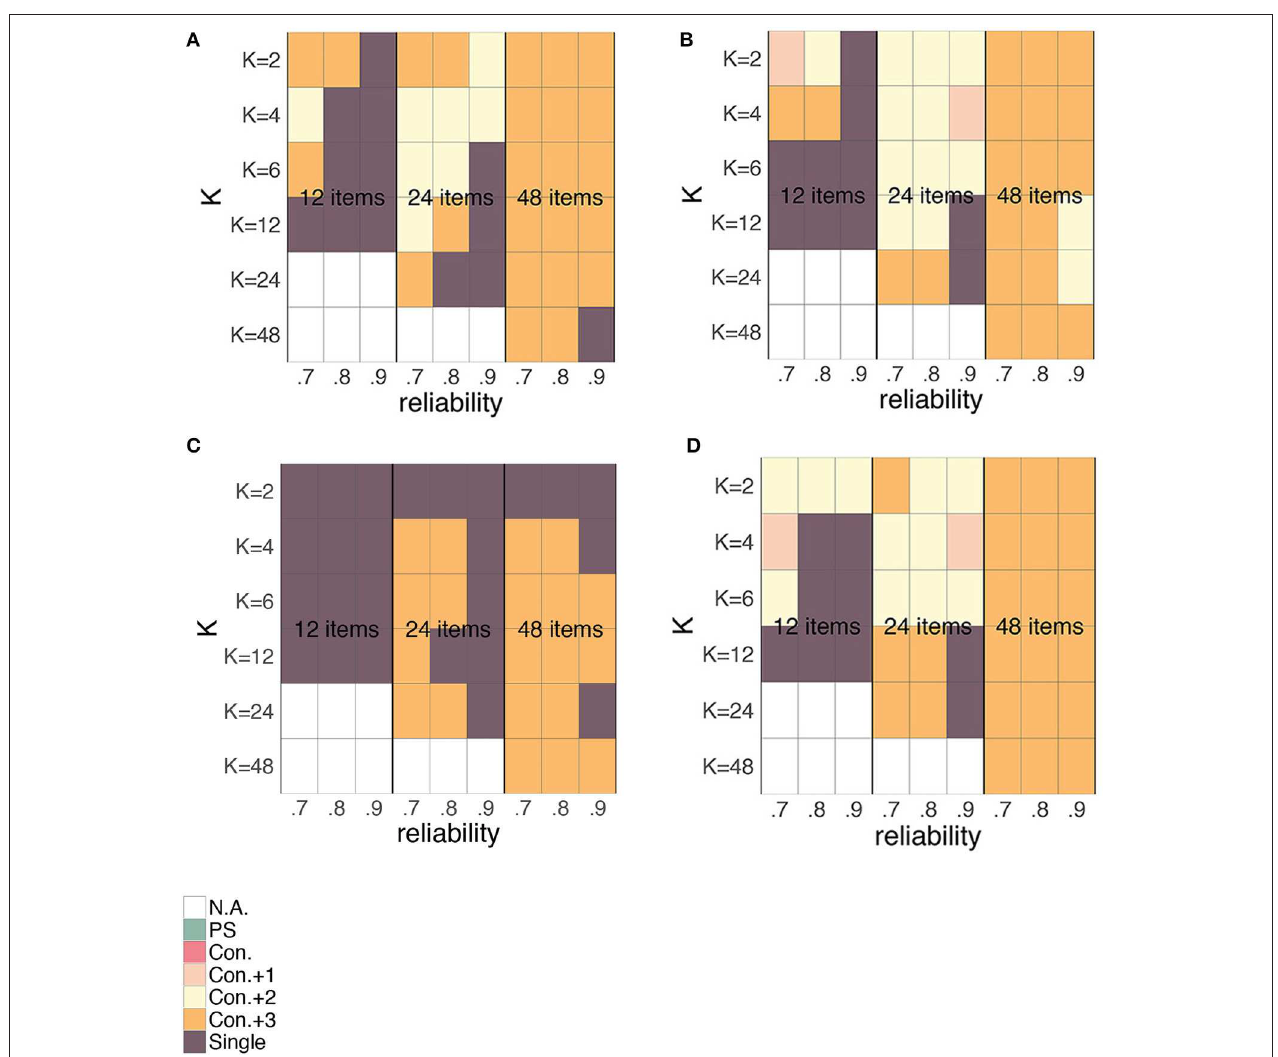
FIGURE 17 | Preference for the person-specific SEm (green), the conditional SEm (pink), the conditional SEm “ + 1” (light pink), the conditional SEm “ + 2” (yellow), the conditional SEm “ + 3” (orange) or the single SEm (purple) based on the MSE for different K ’s, number of items and overall reliability. Plot (A) corresponds to the relationship between “true” scores and error variances as depicted in Figure 5A , (B) to the relationship of Figure 5B , (C) to the relationship in Figure 5C and (D) to the relationship in Figure 5D . All four plots are based on rounded and truncated parallel test